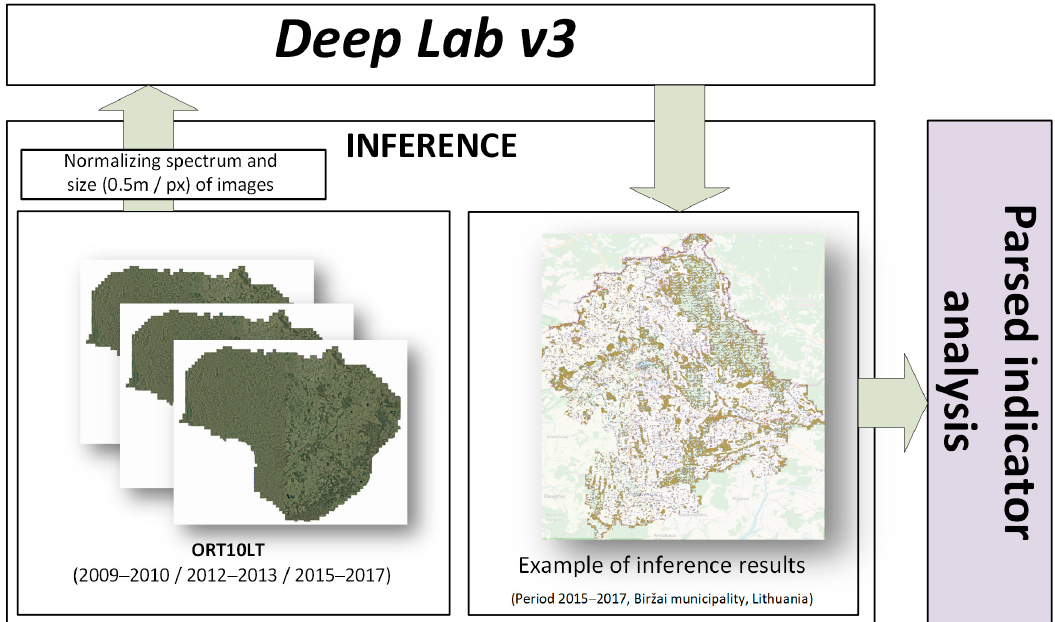
Figure 3. Scheme of ML model application.